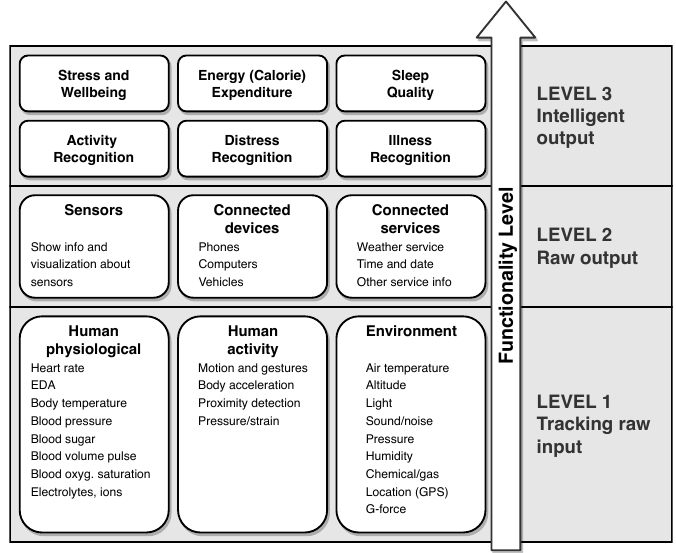
Figure 1. The taxonomy of functionalities of wrist-wearable devices with three levels. Our paper focuses on wrist-wearable devices with Level 3 functionalities of intelligent